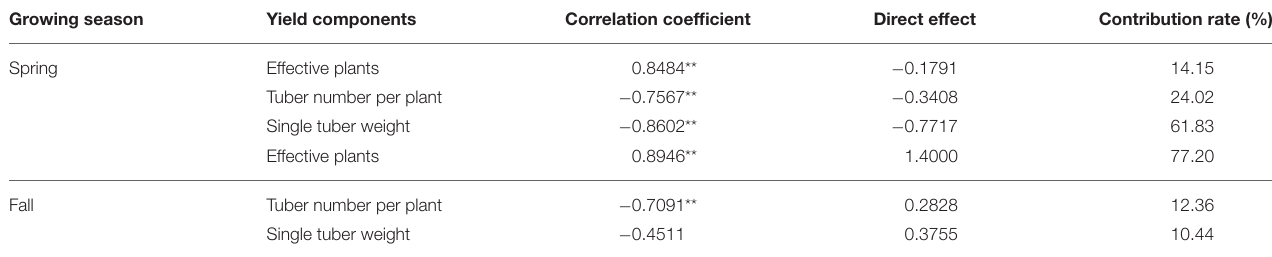
TABLE 4 | Contribution of yield components to yield.